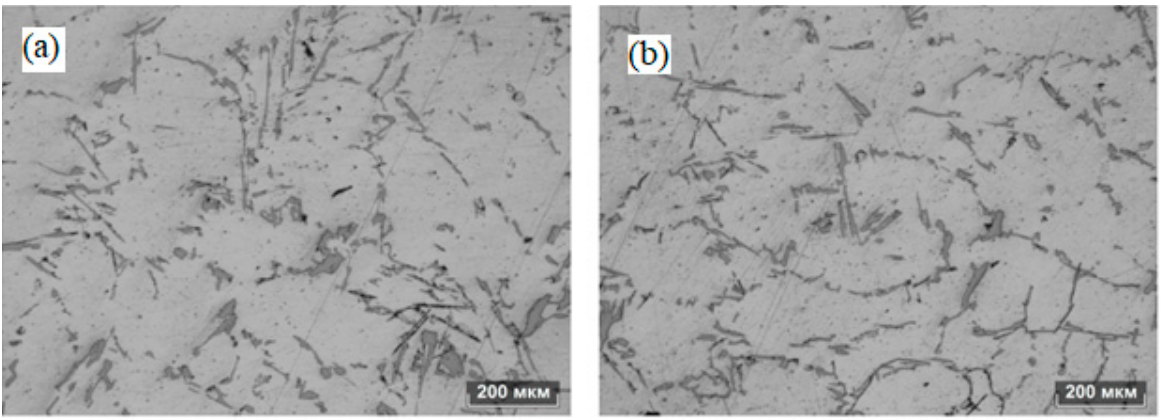
Figure 15. Microstructure of the initial ( a ) and EMP treated ( b ) AlSi12 alloys [18].